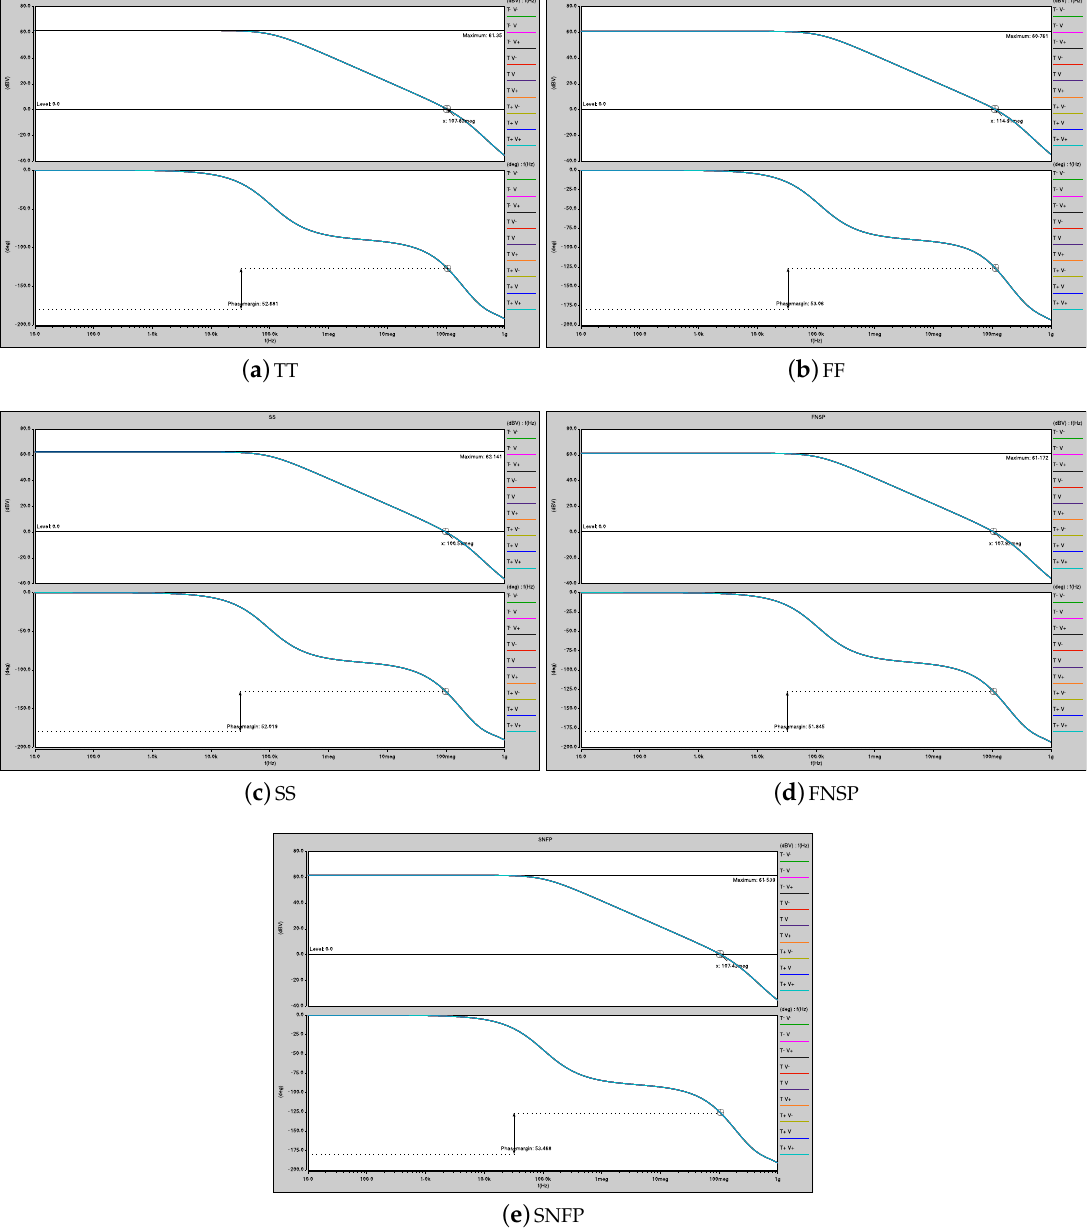
Figure 9. Simulations of process-voltage-temperature (PVT) variations guaranteeing the DCOP given in (2) for the feasible solutions of the Miller